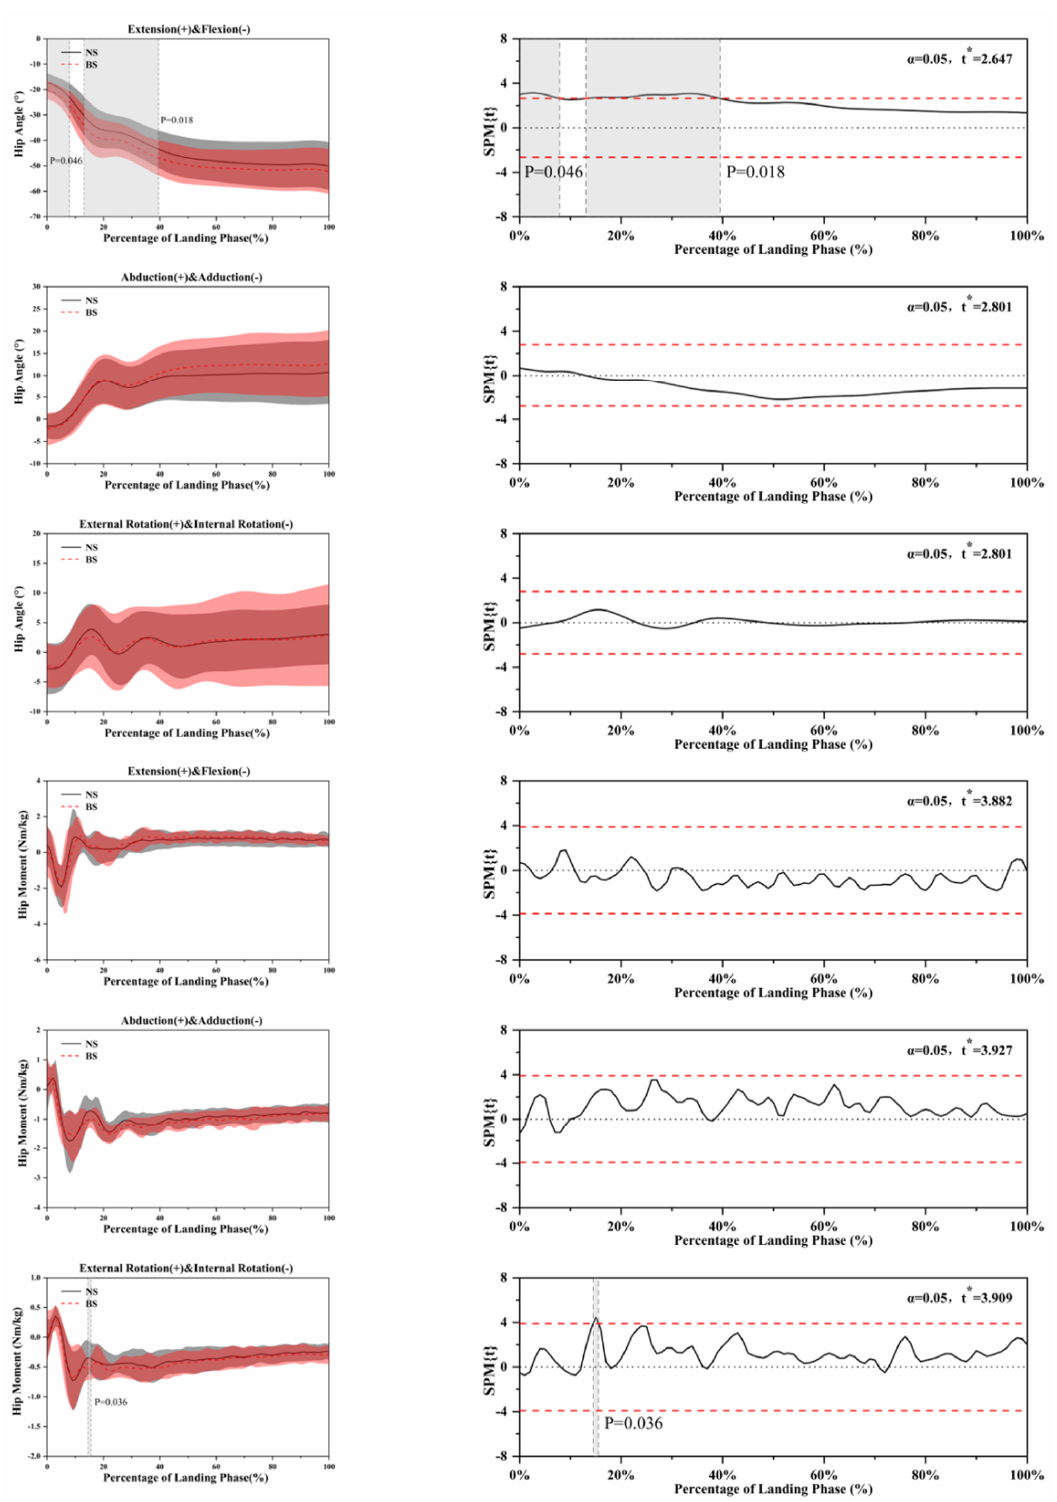
Figure 5. Descriptive results between NS and BS lower-limb statistical parametric mapping results for hip angles and moments during the SLL phase, t -values of the SPM for all participants (post hoc results; dashed red lines represent p = 0.05 level). Grey shaded areas display regions that have statistically significant differences. The scale on the left of each image shows the change in the joint angle and the value of t *. The scale of 0–100 below each image presents an SLL phase.